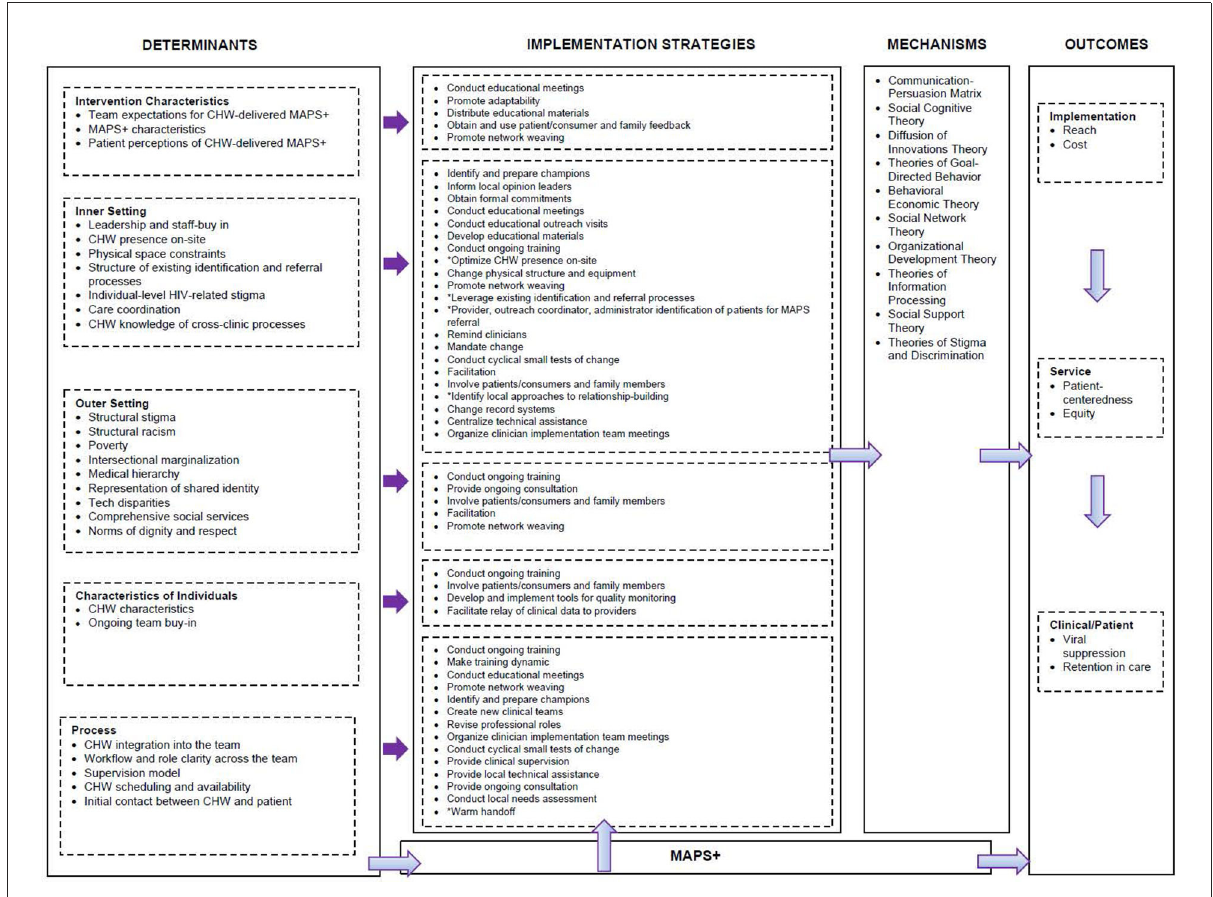
FIGURE3 Logic Model filled in by research team iteratively in lead-up to Stakeholder Meeting